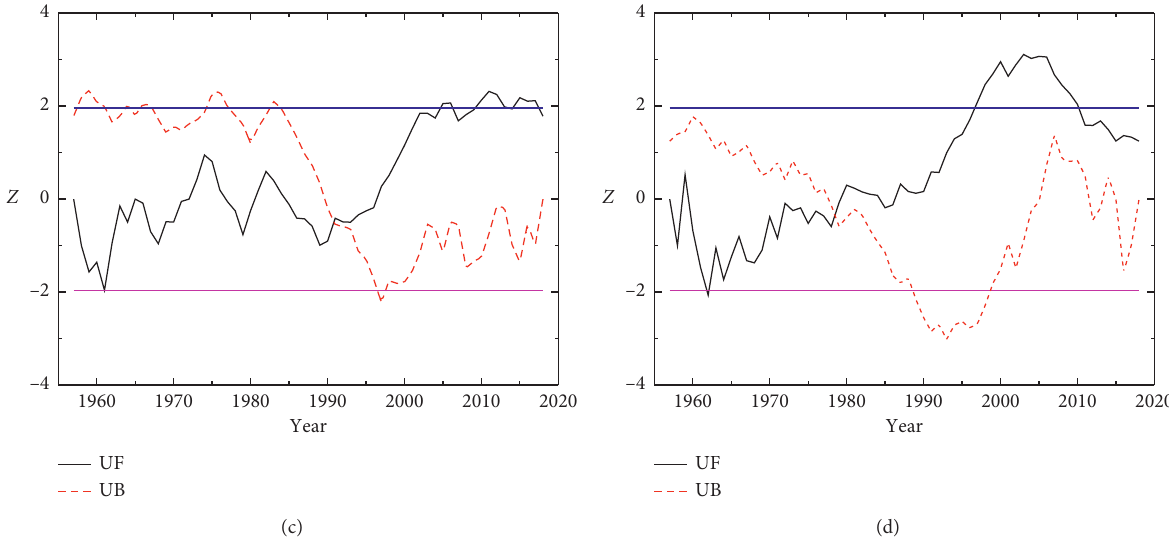
Figure 13: Mann–Kendall test of Ningxia at seasonal scale: (a) spring; (b) summer; (c) autumn; (d) winter.